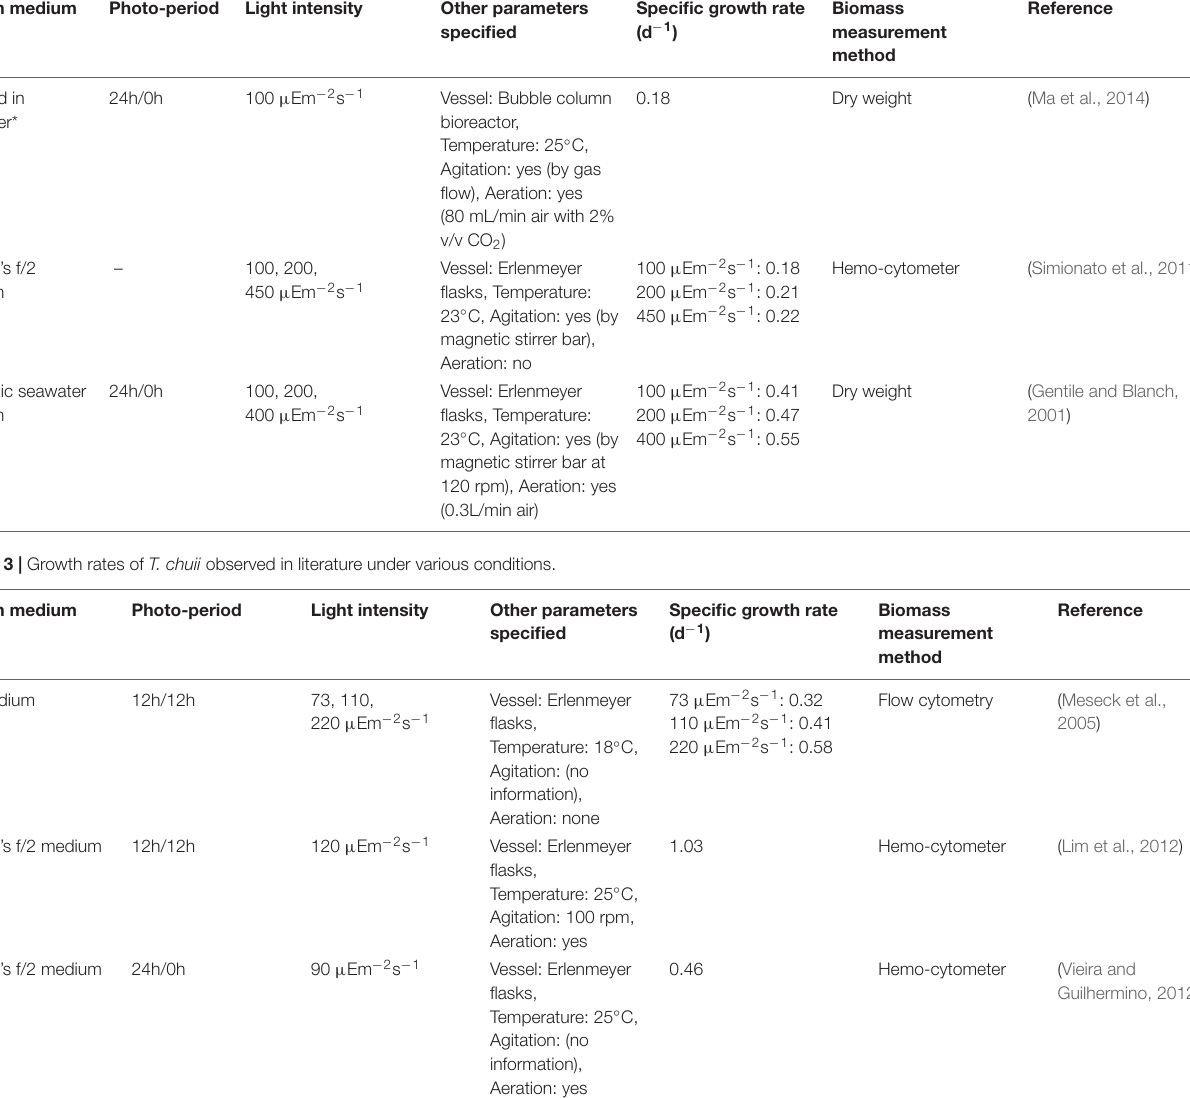
TABLE 2 | Growth rates of N. gaditana observed in literature under various conditions ( ∗ no other information was given). Growth medium